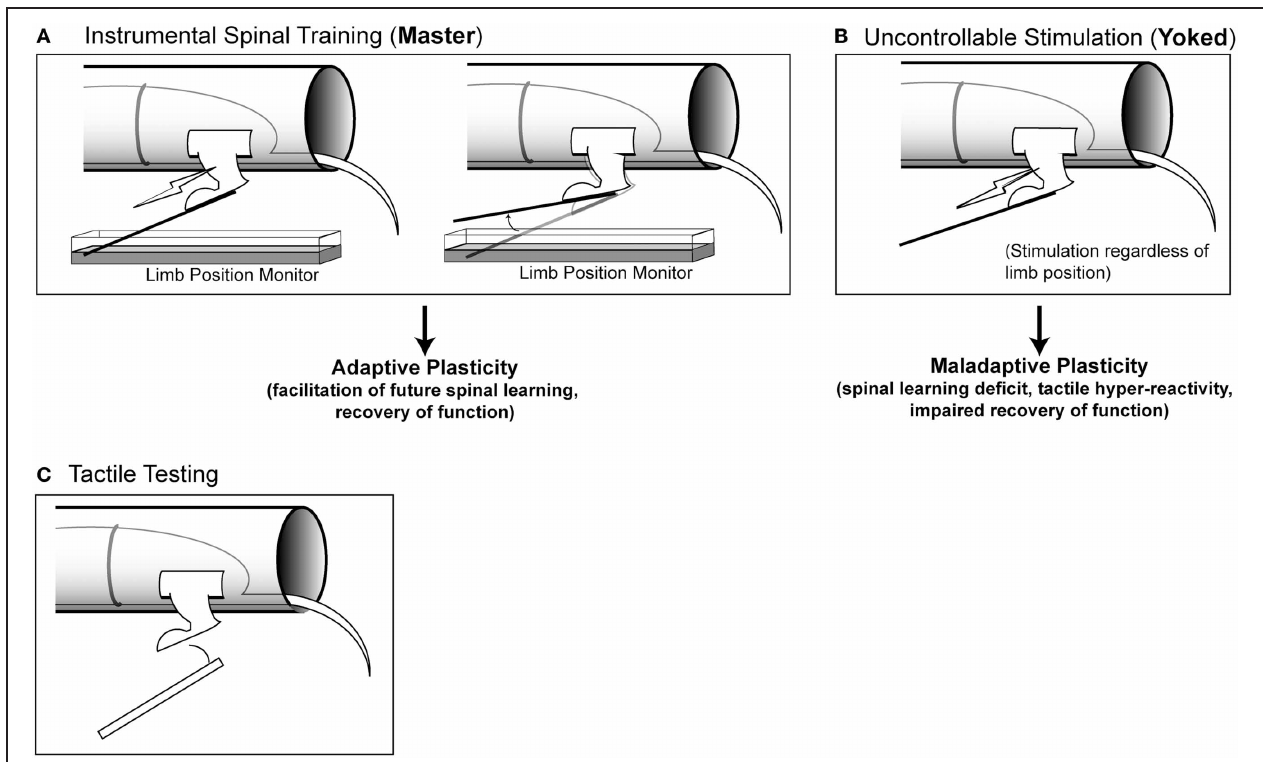
stimulation at the same time as their Master counterparts, regardless of limb position. These rats do not learn a response-outcome association and continue to fail when later tested with controllable stimulation. (C) Tactile testing. To assess hyper-reactivity, calibrated von Frey filaments are used to probe the ventral surface of the hindlimb. Filaments of increasing stiffness are used, until a response is made, and the force necessary to elicit a response is